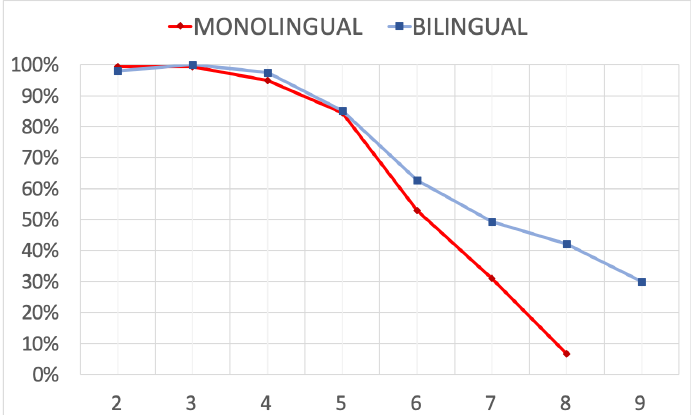
Figure 6. Memory task: mean accuracy for monolinguals and bilinguals for each sequence length.